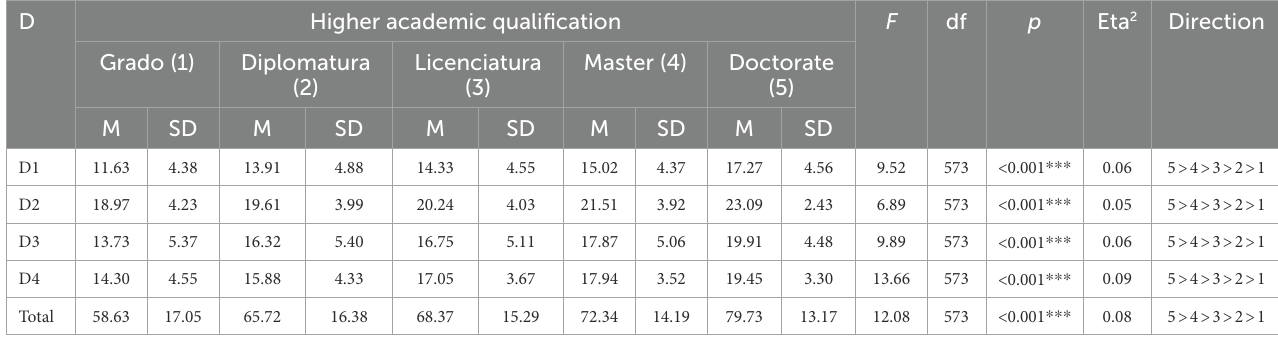
TABLE 7 ANOVA based on the variable highest academic qualification achieved. D Higher academic qualification F df p Eta 2 Direction Grado (1) Diplomatura Licenciatura Master (4) Doctorate (2) (3)